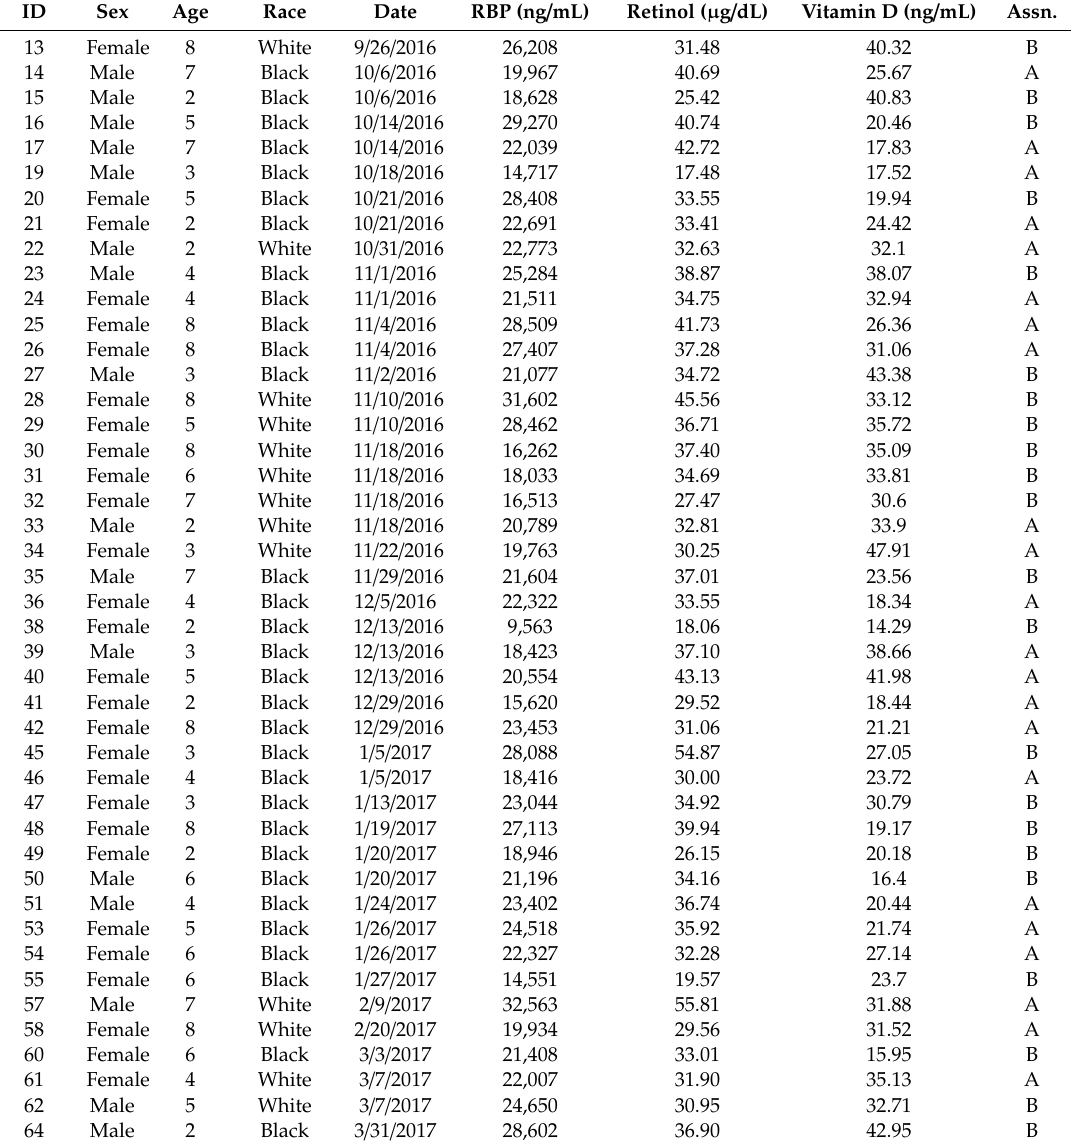
Assignments (Assn.) were A = Placebo, B = Vit